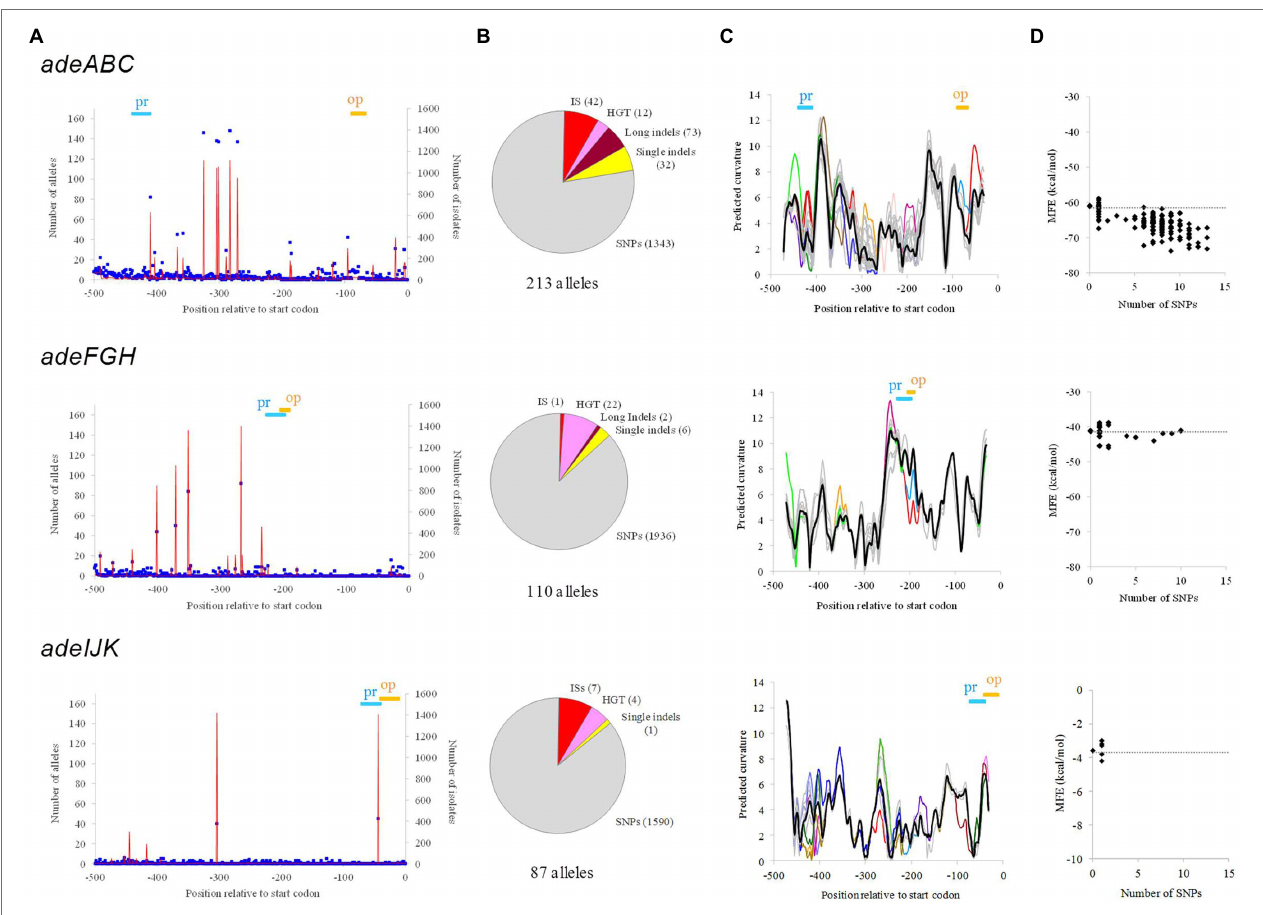
FIGURE 1 | Genetic and structural properties of upstream alleles of Acinetobacter baumannii RND-encoding operons. (A) Location of RND upstream positions showing SNPs. Polymorphisms due to ISs were not included. Allelic occurrence (blue points) and the number of isolates involved (red line) are shown. The positioning of promoter (Pr) and operator (Op) motifs is indicated. (B) Number of alleles and raw genetic events observed for each operon. If more than one type of genetic event pertained the same position, only the most relevant was considered applying the following prevalence: ISs > horizontal gene transfer (HGT) > long indels > single indels > SNPs. (C) DNA bending calculations for all allelic sequences showing no indels respect to the WT. Curvature is expressed in degrees per helical turn. Thick black line: allelic average (nearly identical to the WT values); superimposed alleles are in grey except for those showing maximal divergences of ≥ 2 degrees/turn with respect to the allelic average or ≥ 1 degree/turn in key motifs, which were color-highlighted. The positioning of promoter (Pr) and operator (Op) motifs is also indicated. (D) Minimum free energy (MFE) of the mRNA structure for all allelic sequences showing no indels respect to the WT. Black dots indicate MFE values and the number of SNPs respect to the WT for each allele. The MFE value for the WT is indicated (grey